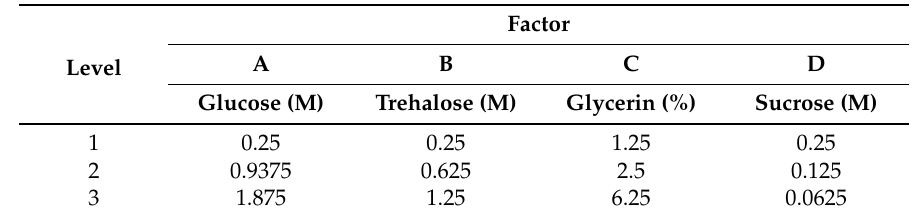
Table 1. Factors and levels of the L9 (3 4 ) orthogonal test.